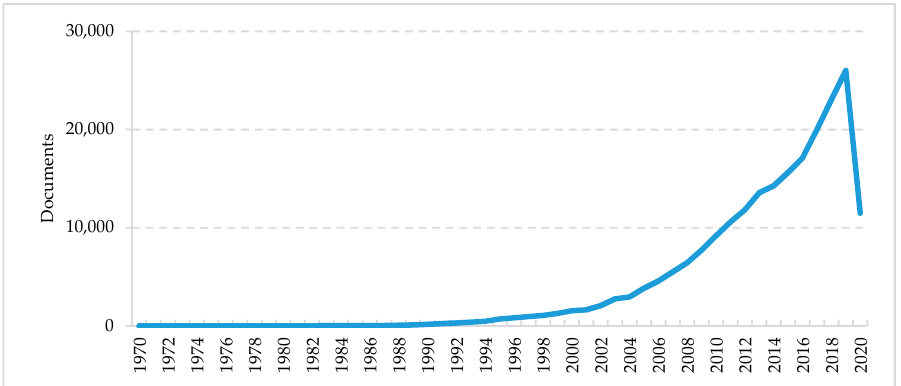
Figure 1. Documents published on sustainability between 1970 and 2020.